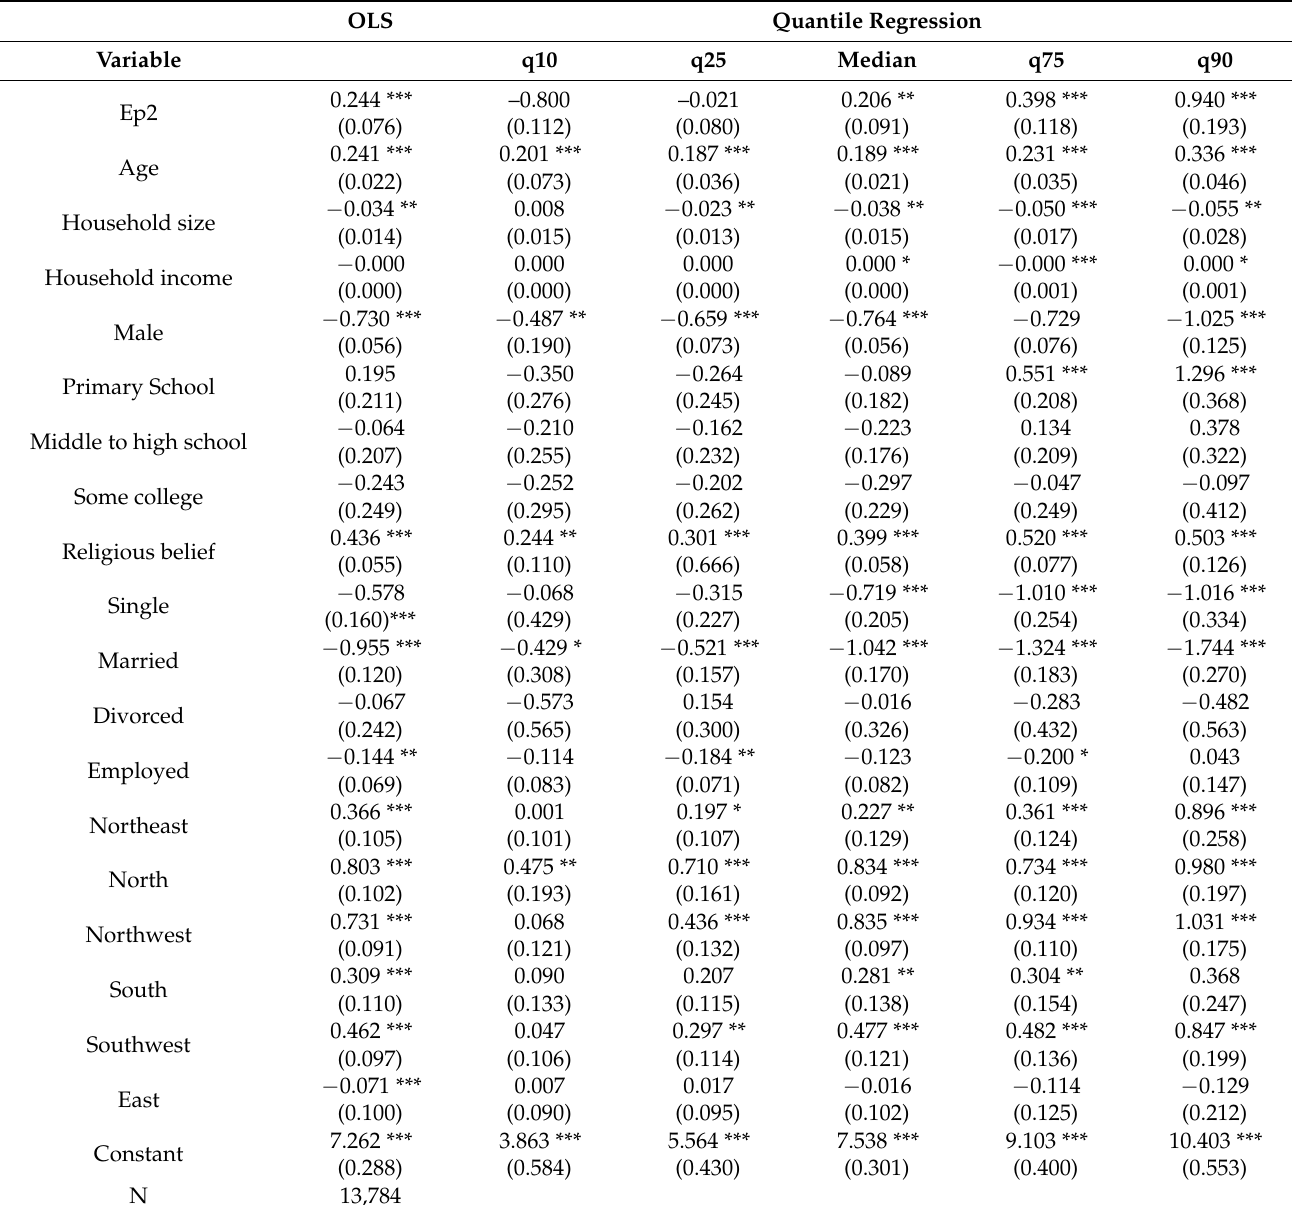
Table A2. Estimated parameter coefficients from the OLS and quantile regression models with EP2 as energy poverty